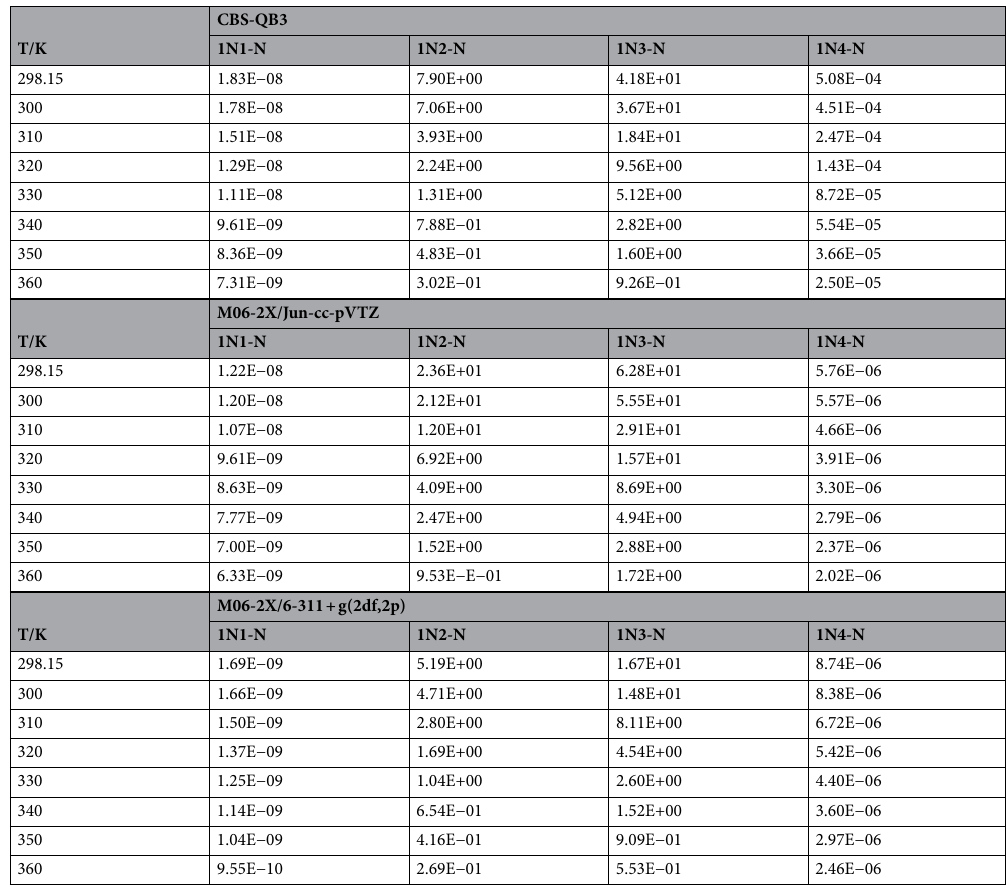
Table 3. Half-lifes (in s) of the predicted intermediates in 1,4-H shift of 3-hydroxyl-1H-pyrrol-2(5H)-one at the CBS-QB3, M06-2X/Jun-cc-pVTZ, and M06-2X/6-311 + g(2df,2p)